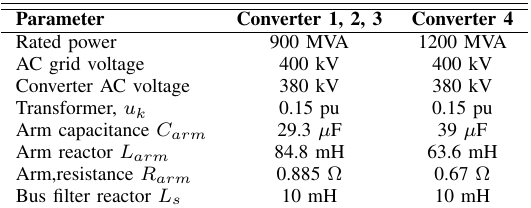
TABLE II F OUR -T ERMINAL HVDC S YSTEM P ARAMETERS [14] Parameter